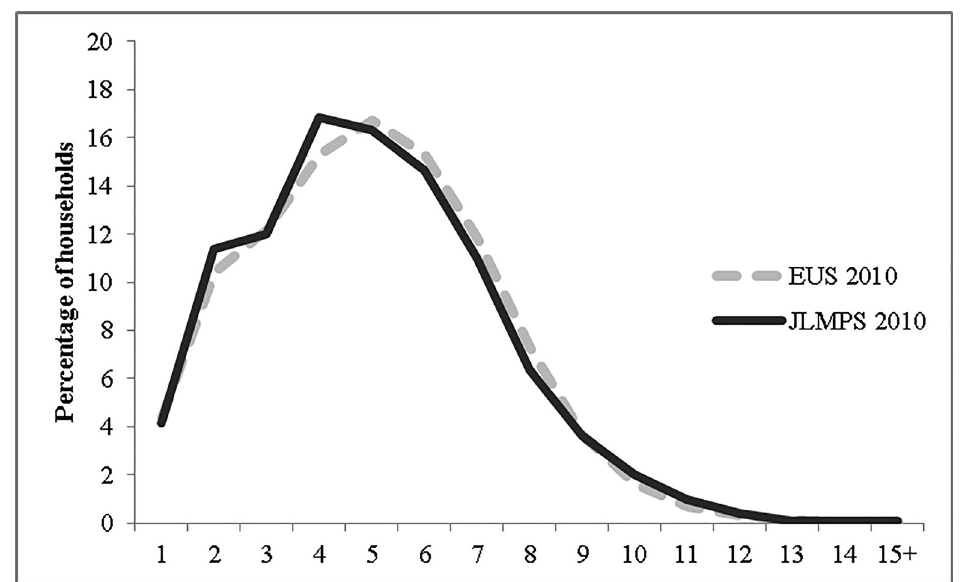
Figure 3 Comparison of household size (percentage of households), Jordanians, by 2010 data